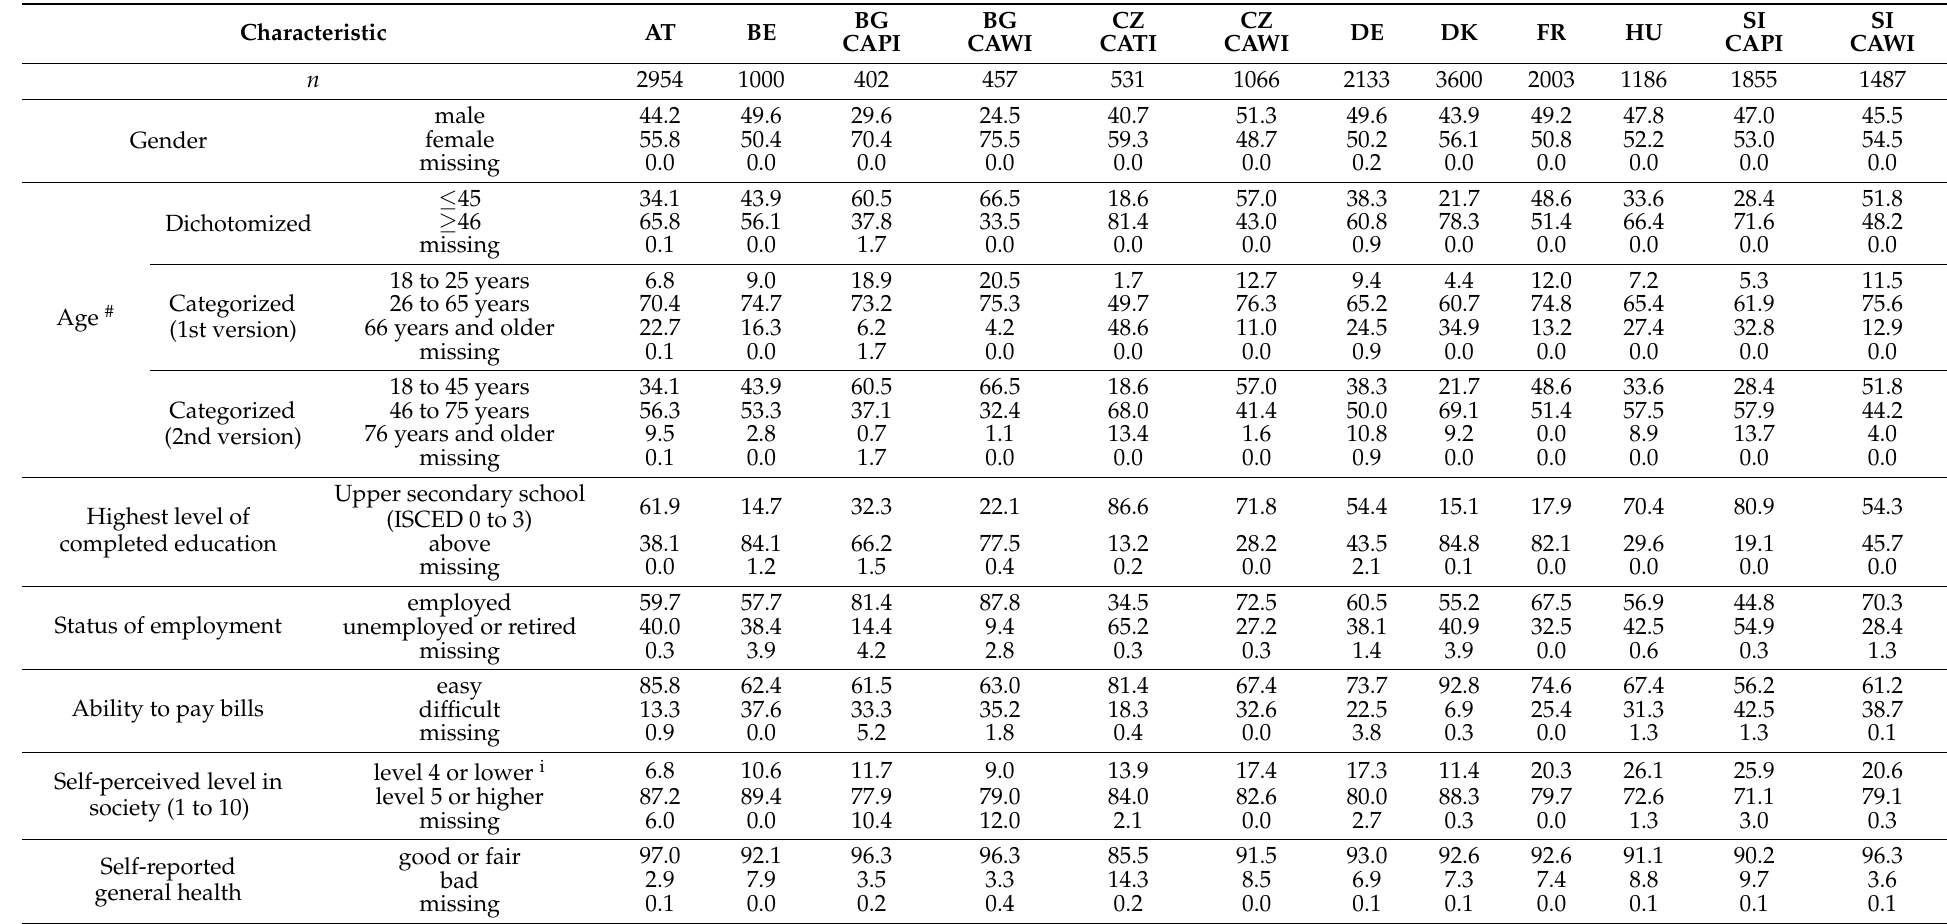
Table 3. Sample characteristics (in percentages) for the participating countries in HLS 19 , measuring HLS 19 -COM-P, divided by data collection mode.